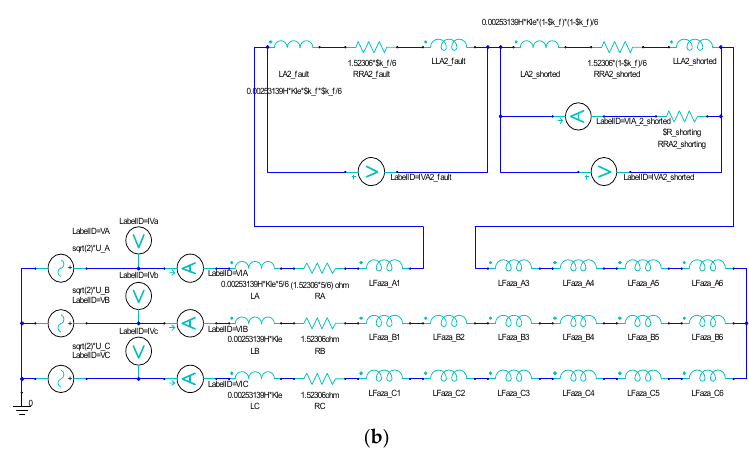
Figure 2. Field–circuit model of induction machine: ( a ) magnetic circuit and ( b ) electric circuit. Table 1. Rated parameters of the motor.